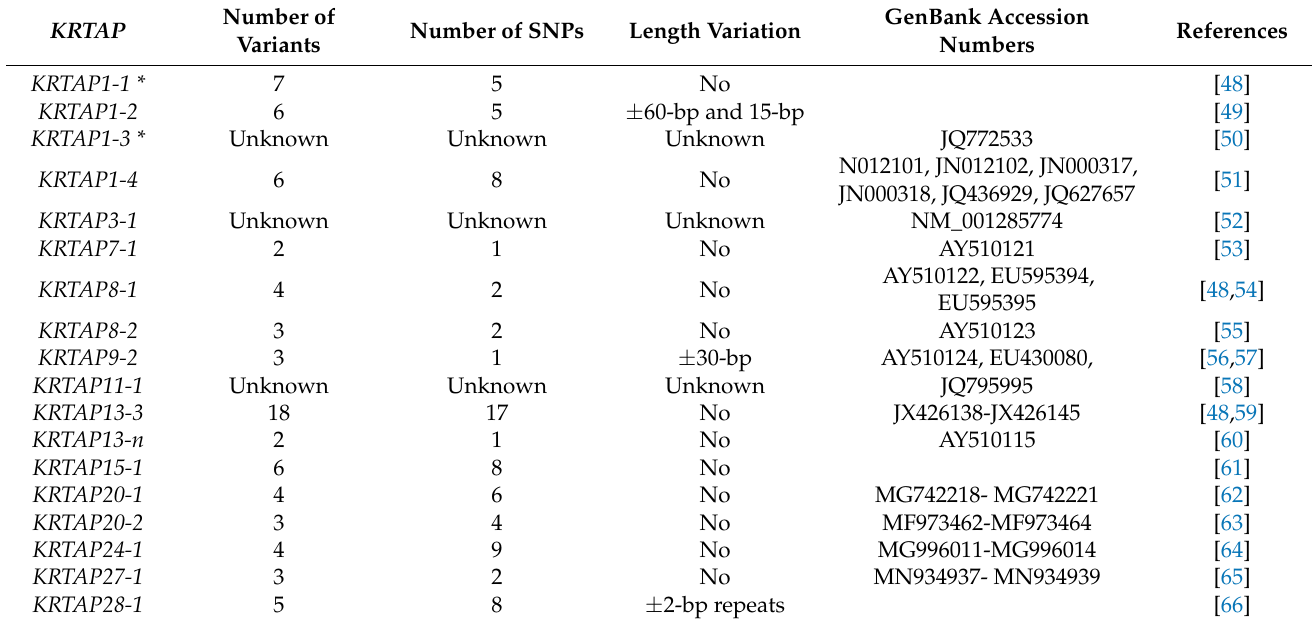
Table 2. The caprine KRTAP s that have been